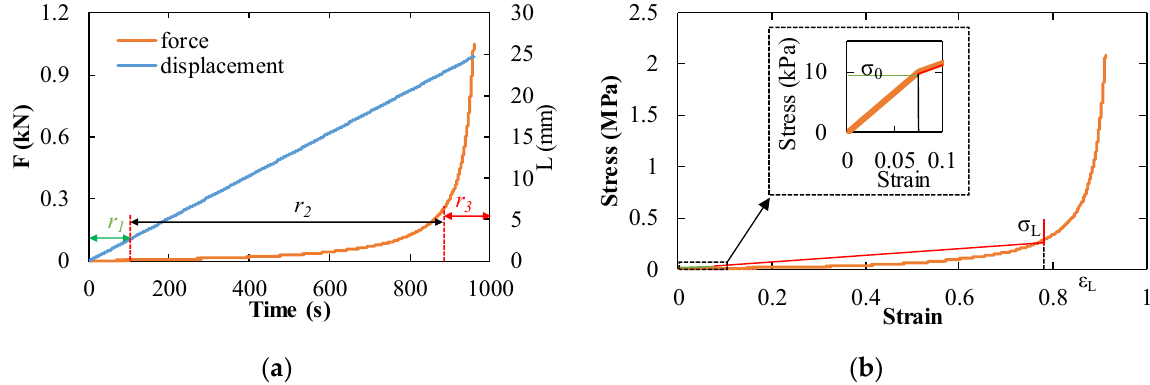
Figure 6. The mechanical response characteristics of foam materials in quasi-static experiments under a strain rate of 10 − 3 s − 1 : ( a ) The diagram of the force and the displacement of foam materials as a function of the time, r 1 is the linear phase, r 2 is the plateau phase, and r 3 is the density phase, the orange line represents the force of the specimen, and the blue line represents the compression displacement of the specimen. Moreover, the whole deformation process of foam exhibited the linear phase, the plateau phase, and the density phase, respectively; ( b ) the diagram of the stress of the foam as a function of the strain, the yield stress σ 0 is 0.00998 MPa, the locking stress σ L is 0.27 MPa, and the locking strain ε L is 0.78.